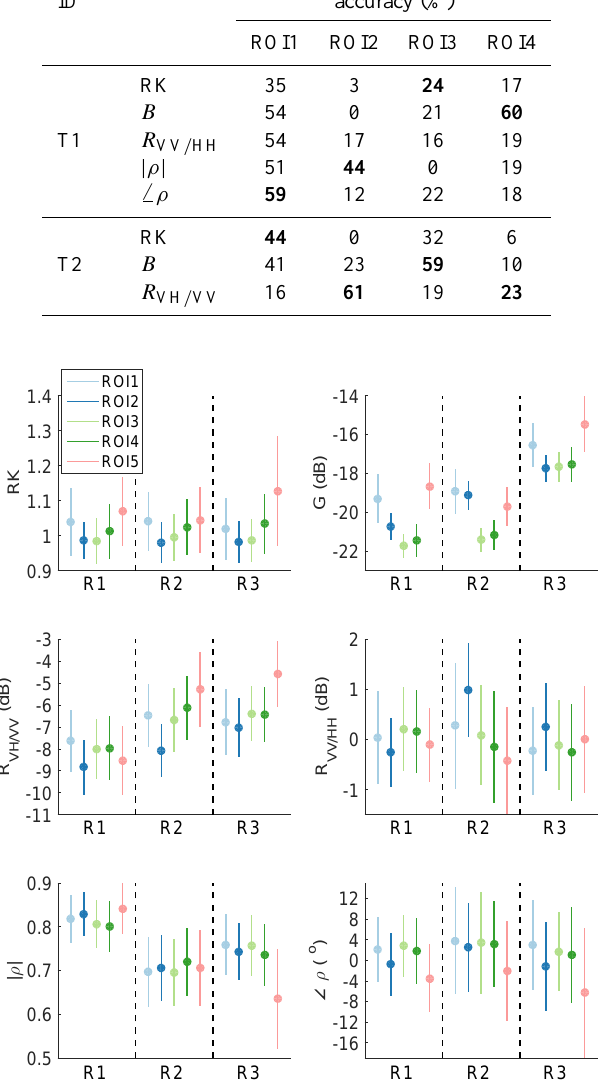
Figure 6. Mean values of the features in the regions of interest in the three RADARSAT-2 scenes (R1, R2 and R3). The error bars are 2 standard deviations